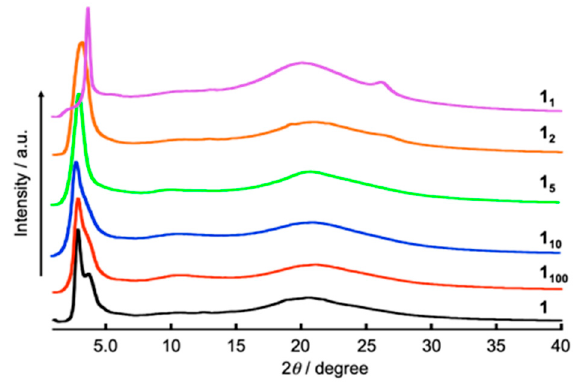
Figure 5. X-ray di ff raction (XRD) patterns of 1 12 and complexes of 1 12 with BSA for 1 12 100 , 1 12 10 , 1 12 5 , Figure 5. X-ray diffraction (XRD) patterns of 1 12 and complexes of 1 12 with BSA for 1 12100 , 1 1210 , 1 125 , 1 122 1 12 2 and 1 12 1 at room and 1 121 at room temperature. Table 1. Phase transition behavior and d values estimated from XRD for 1 12 and complexes of 1 12 with BSA.